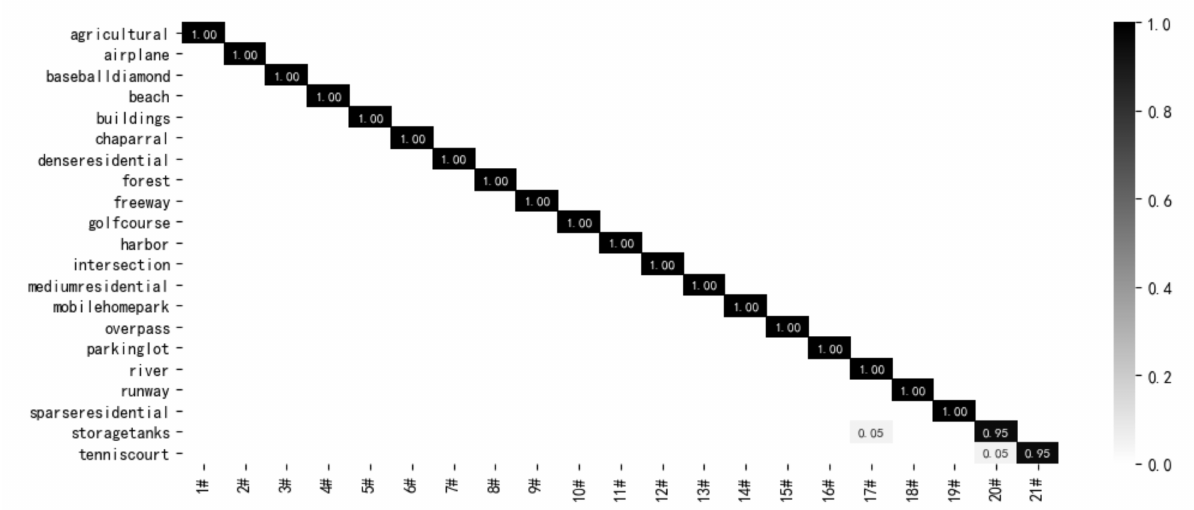
Figure 6. Confusion matrix of the LCNN-CMGF method on the UCM21 dataset (80/20).